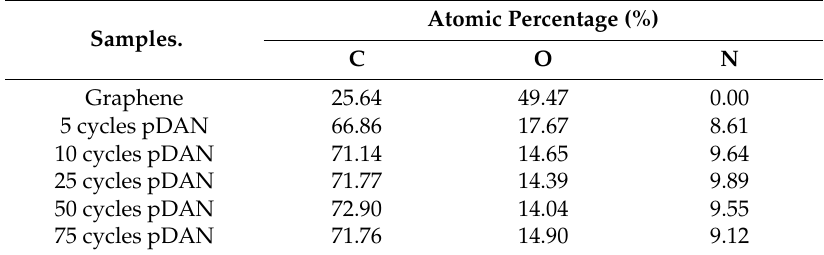
Figure 3. XPS spectrum showing ( a ) wide scan, ( b ) C 1s, ( c ) O 1s, and ( d ) N 1s spectrum of CVD graphene and pDAN functionalized graphene at different scan cycles. Table 1. Carbon, oxygen and nitrogen atomic percentages for untreated and pDAN functionalized CVD graphene. Atomic percentages were determined using XPS